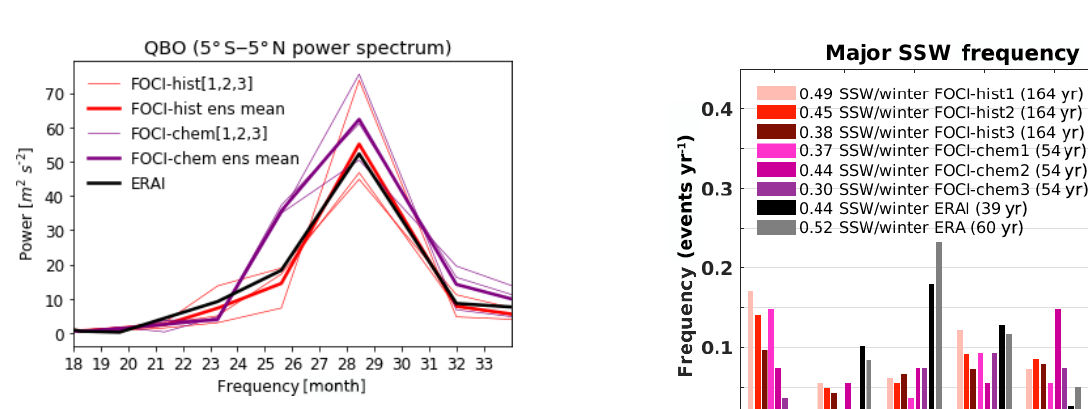
Figure 18. QBO spectrum calculated using Welch’s method (Welch, 1967) for FOCI-hist (1960–2013; red) and FOCI-chem (1960–2013; purple) simulations as well as ERA-Interim (solid line; 1979–2017) (thin lines are single experiments; thick lines are the ensemble means). For the QBO, the zonal mean zonal winds from 5 ◦ S to 5 ◦ N and 50hPa are used.